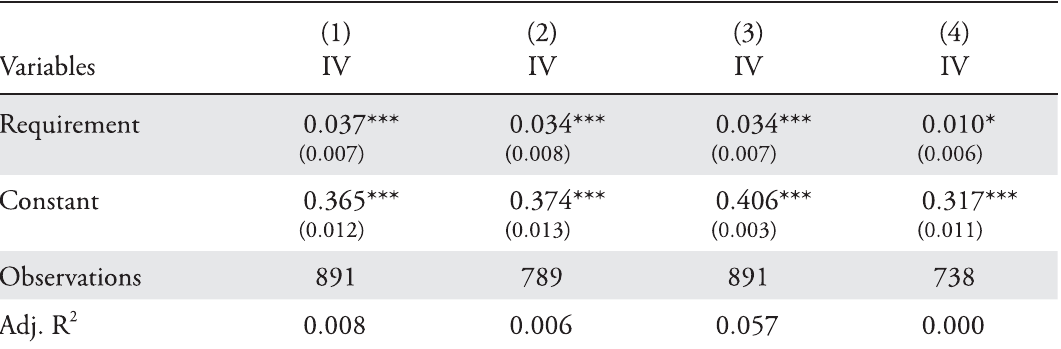
Table 8: IV Estimation-